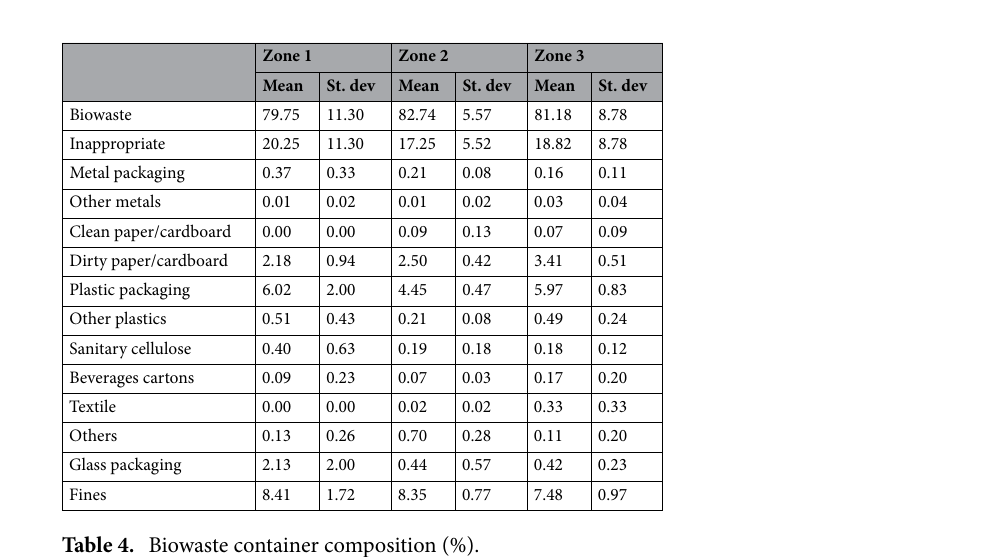
Table 4. Biowaste container composition